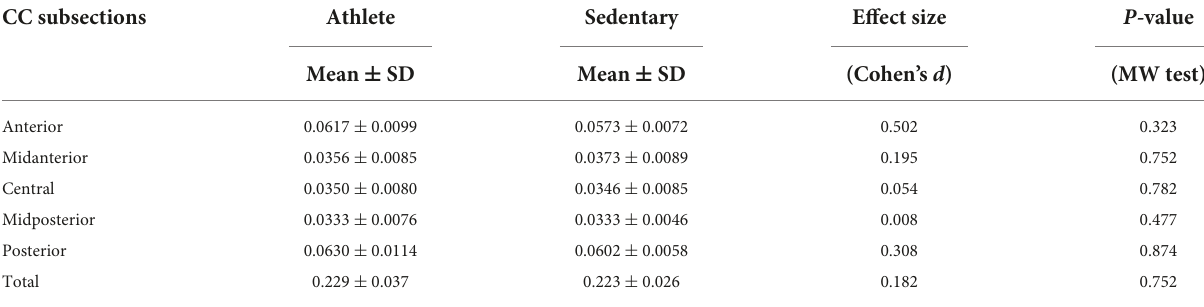
TABLE 3 Subsection and total volumes of the corpus callosum computed from T1-weighted structural image data in the athlete and sedentary